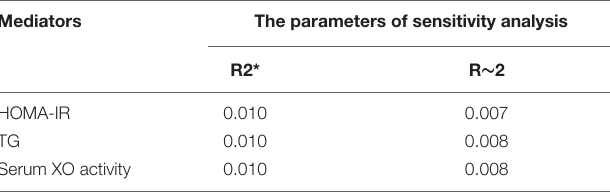
TABLE 2 | The sensitivity analysis for mediation analysis. Mediators